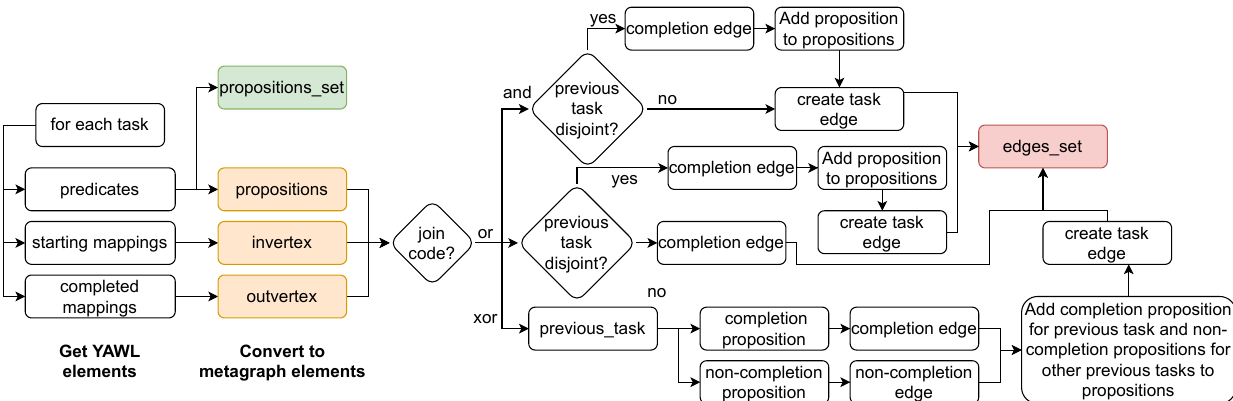
Figure 12. Flowchart of transformations from YAWL to a metagraph. For each task, relevant elements of the YAWL language are identified, and converted to metagraph elements. The join code indicates the join operation of the currently processed task, which is then used to determine the actions to perform in each possible case (AND, OR,